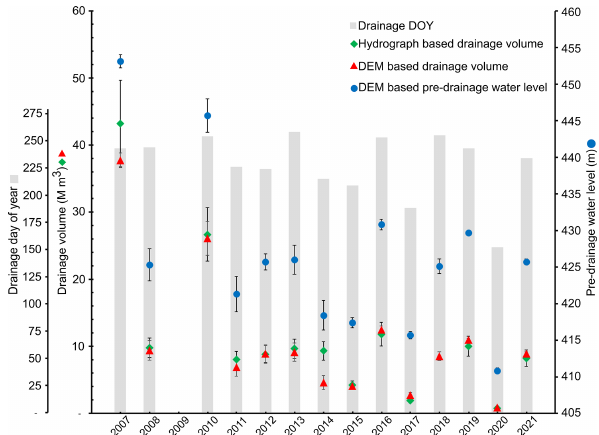
Figure 3. Pre-drainage water level, drainage volume, and drainage day of year (DOY) for 14 GLOFs spanning 2007 to 2021. Pre- drainage water levels (blue circles) are estimated using the 2021 post-drainage DEM. Drainage volumes are estimated using both the 2021 post-drainage DEM (red triangles) and downstream hy- drograph observations (green squares). The grey bars indicate the day of year (DOY) of the drainage and refer to the leftmost y axis. No hydrograph data for the 2018